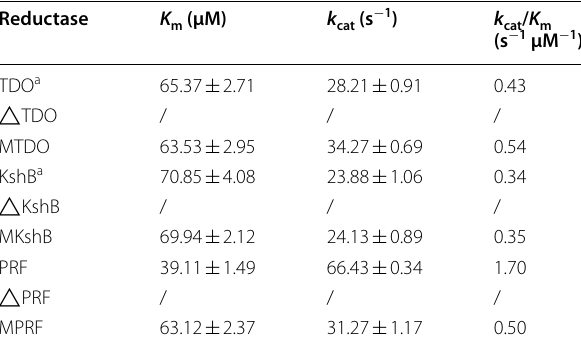
Data are shown as the mean a Data from Zhu et al.